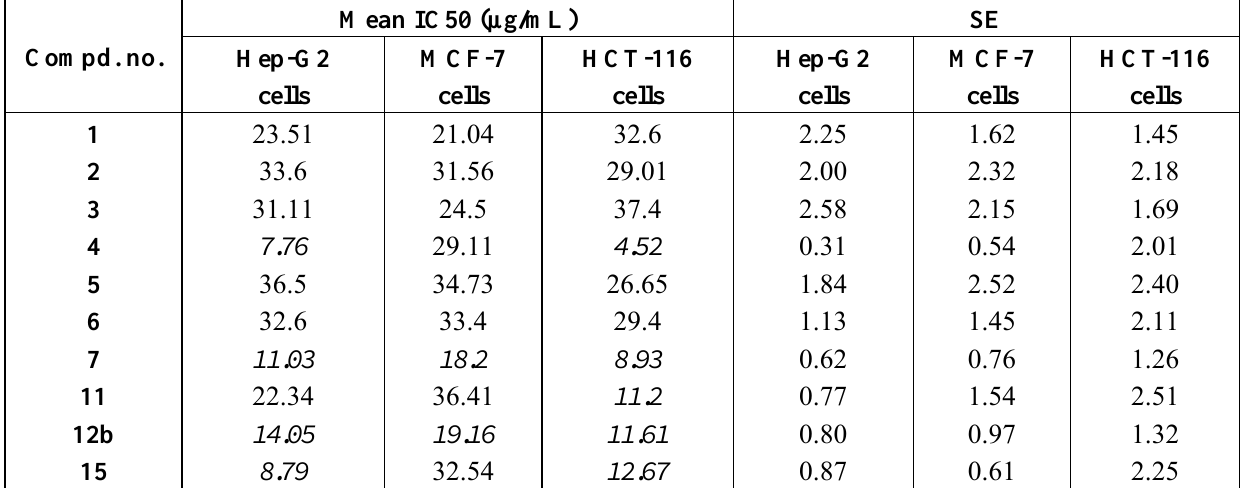
Table 1. Cytotoxicity test using MTT assay against three different human cancer cell lines. Compd. no.